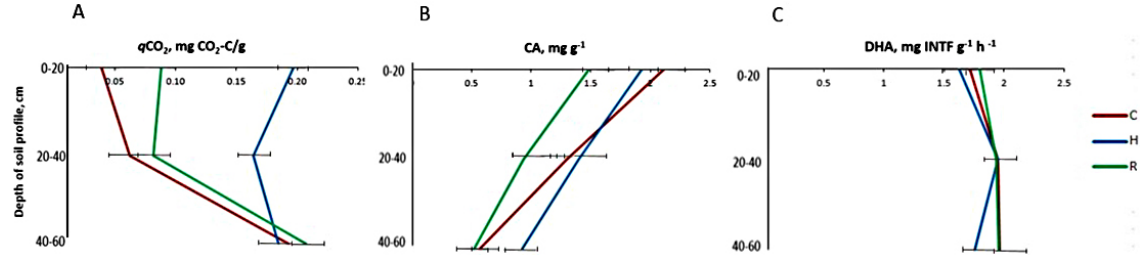
Figure 2. Microbial characteristics of the soil sampled from columns C (uncontaminated soil), H (contaminated by the raw waste containing oily compounds and radionuclides), and R (contaminated by treated waste containing mainly radionuclides) in different layers [upper (0– 20cm; u ), middle (20–40cm; m ), and lower (40–60cm; l )]. A – metabolic quotient ( q CO 2 ) , B – cellulase activity (CA), C – dehydrogenase activity (DHA).